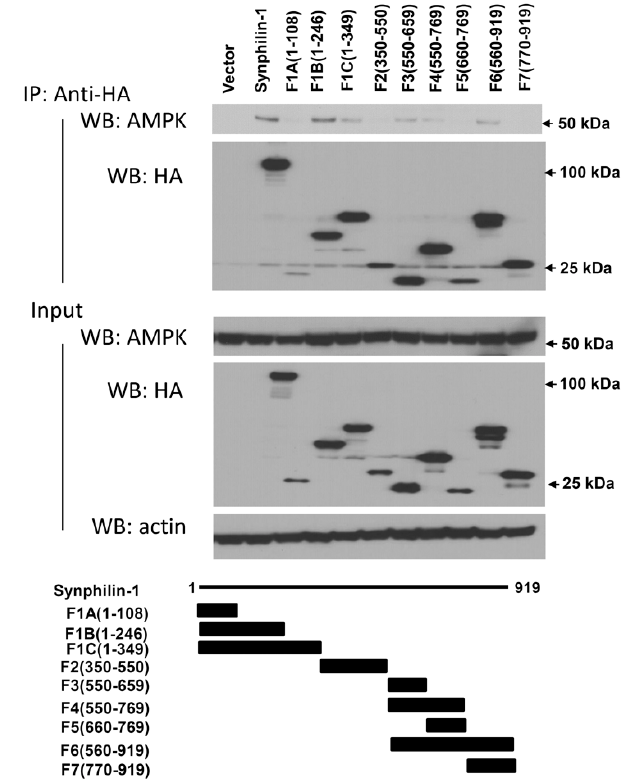
Figure 3. Map of the region of synphilin-1 interacting with AMPK. Lysates prepared from HEK 293 cells transfected with HA-tagged human full length or truncated synphilin-1 constructs were subjected to IP with anti-HA antibody, followed by anti-AMPK and anti-HA immunoblotting. The input of equal protein loading from cell lysates was shown by Western blot using anti-AMPK, anti-synphilin-1, and anti-actin antibodies.